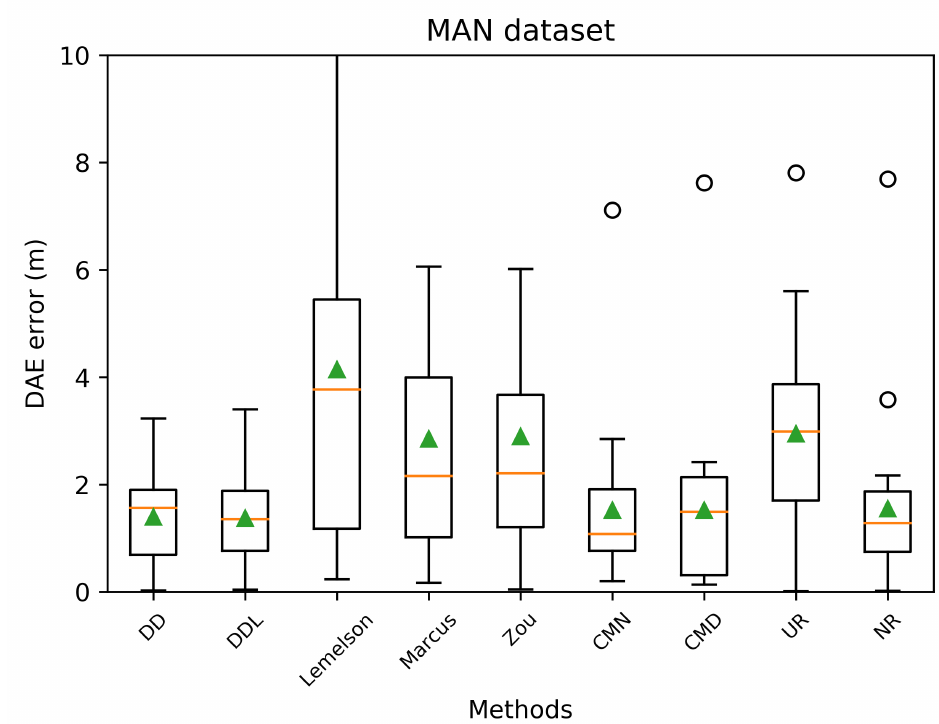
Figure 21. Boxplots indicating the distribution of the absolute DAE error of all studied methods and baselines, in the validation set of the MAN dataset. The green triangles indicate the mean values while outliers are depicted as black circles.